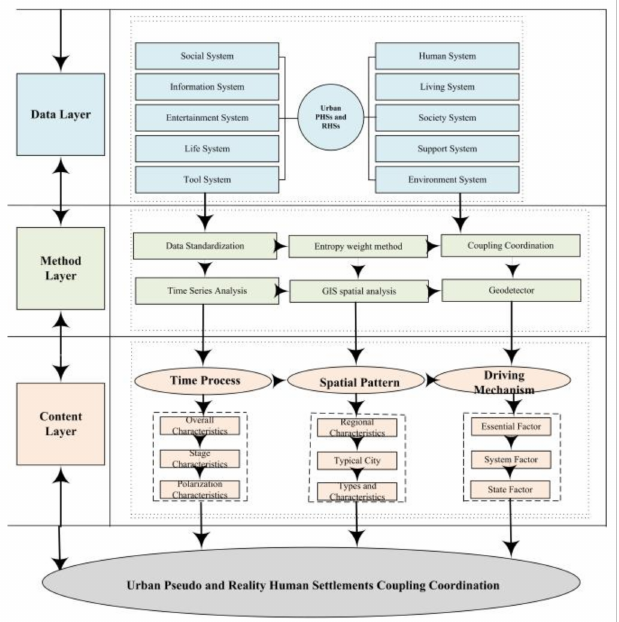
Figure 4. The technology framework of coupling coordination of urban PHSs and